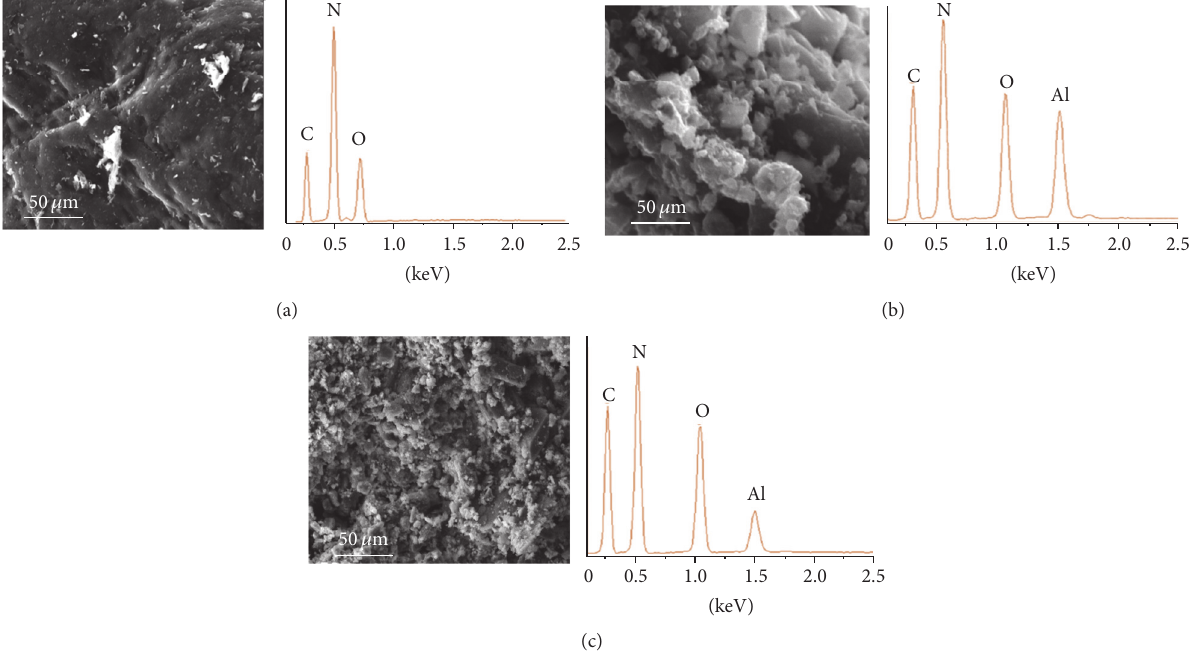
Figure 4: The SEM images and corresponding EDS spectra of chitosan (a), chitosan-alumina (b), and chitosan-alumina/f-MWCNTs (c).